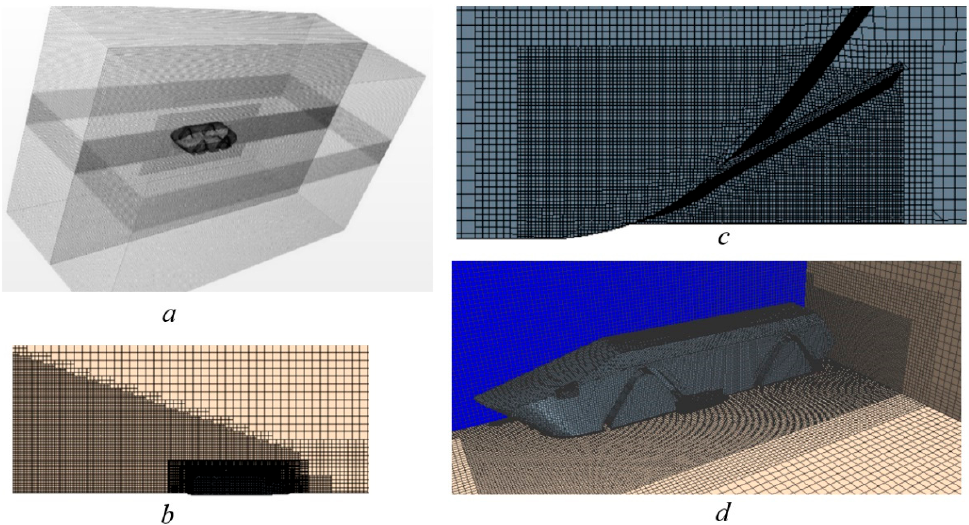
Figure 7. Diagram of mesh. ( a ) Overall mesh; ( b ) Kelvin wave system; ( c ) Encryption area of Flanks; ( d ) Mesh of the hull.